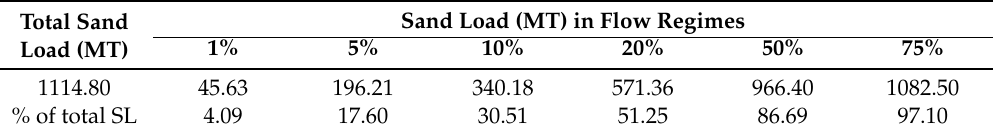
Table 5. Sand transport within 1%, 5%, 10%, 20%, 50%, and 75% flow regimes at Tarbert Landing of the LmMR from 1973 to Table 4. Sand transport under five river stages at Tarbert Landing of the LmMR from 1973 to 2013. Flow Stage